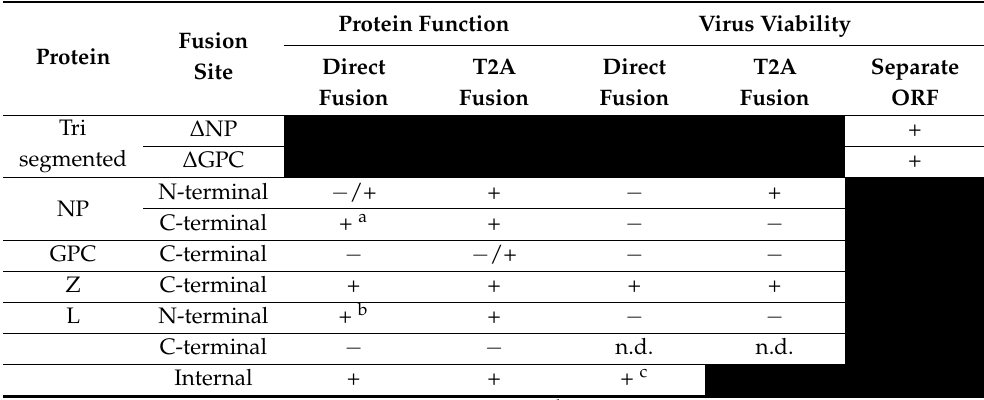
Table 1. Summary of strategies to generate TCRV reporter proteins and viruses. Protein Function Virus Viability Fusion Protein Direct T2A Site Fusion Fusion